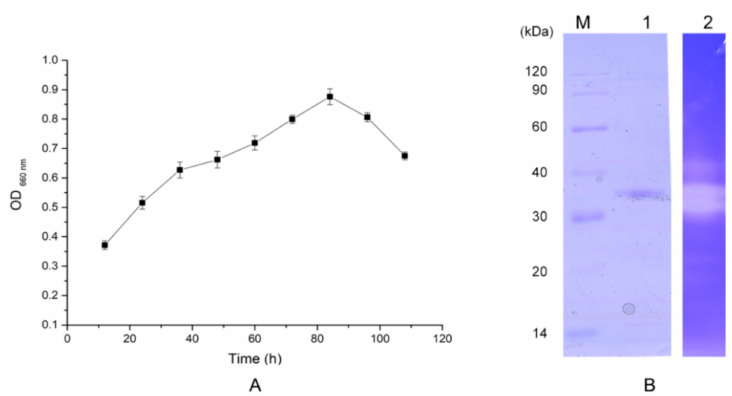
Figure 2. ( A ). Time-related changes in the relative activities of extracellular protease produced by Pseudoalteromonas sp. H2. by the Folin phenol method. ( B ). SDS–PAGE and zymography analyses of EH2. Line marked 1, SDS-PAGE; line marked 2, casein immersing zymography. Values are expressed as the mean ± SD ( n =